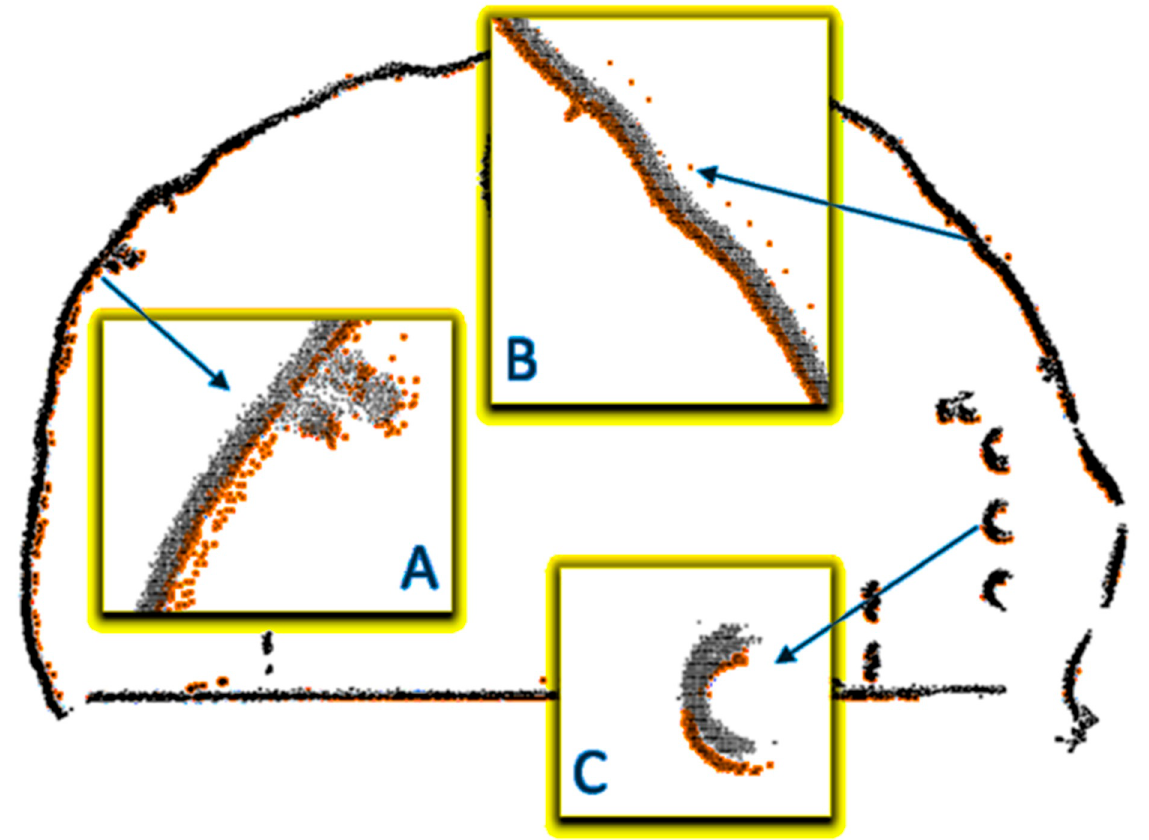
Figure 5. Start section, measurements (orange: TLS cloud; black: PLS cloud). Table 5. PLS/TLS comparison results.